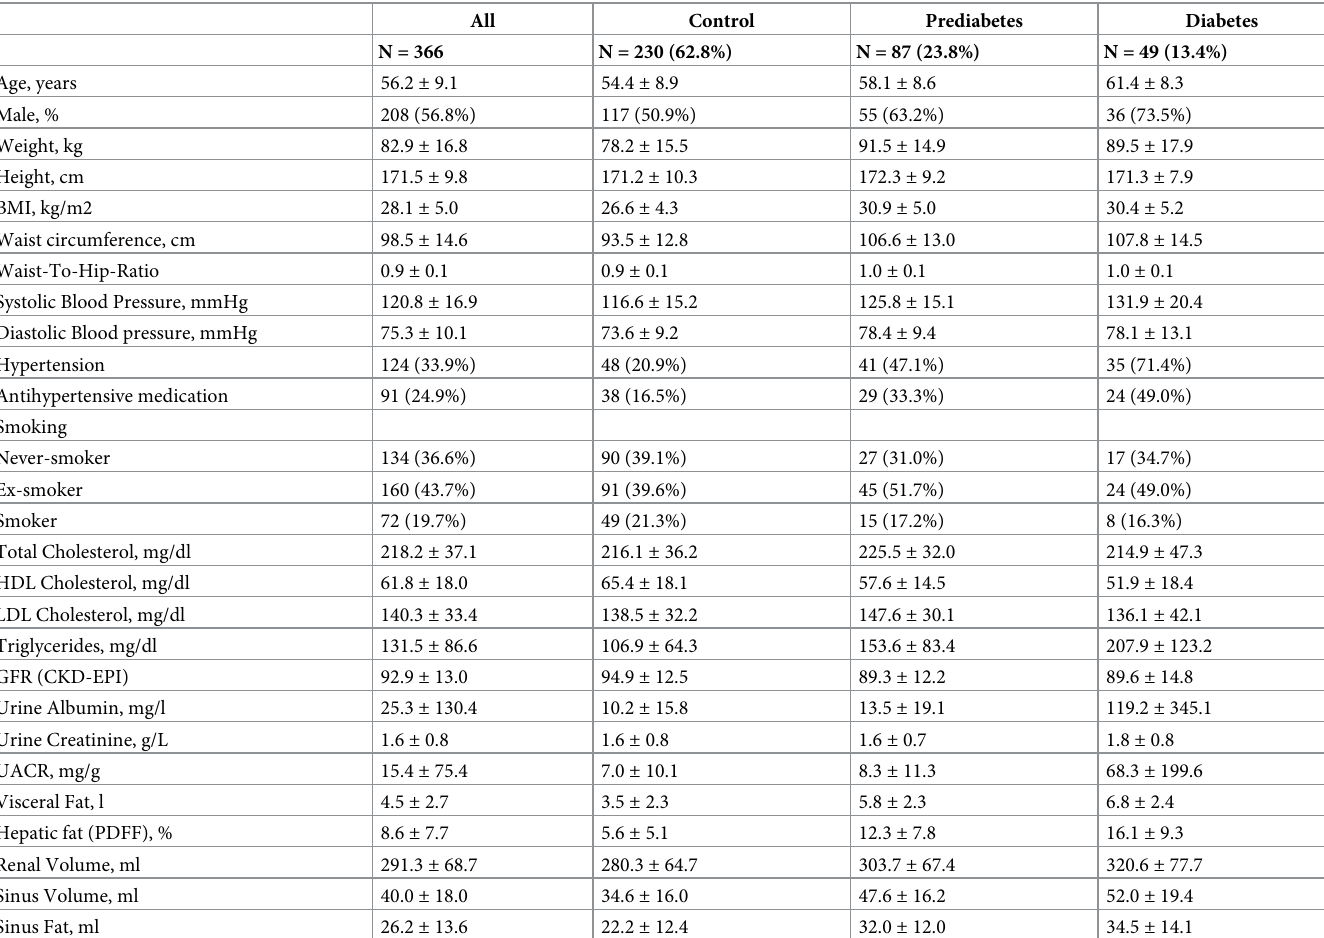
Table 1. Demographics, cardiovascular risk factors and MRI parameters of the study participants.